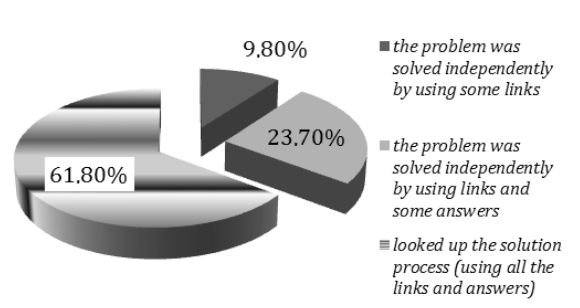
Figure 8. Reasons for not opening this activity TABLE I. C OMPARISON OF I NTERESET IN P RACTICAL P ROBLEM S OLVING IN M ATHEMATICS AND A VERAGE S UCCESS IN M ATHERMATICS IN